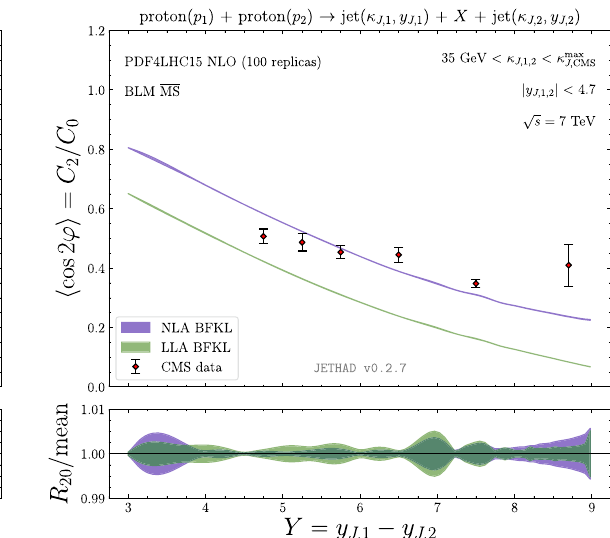
are done in the MS renormalization scheme. Ancillary plots below pri- mary panels show the reduced azimuthal correlations, i.e. the envelope of R nm replicas’ results divided by their mean